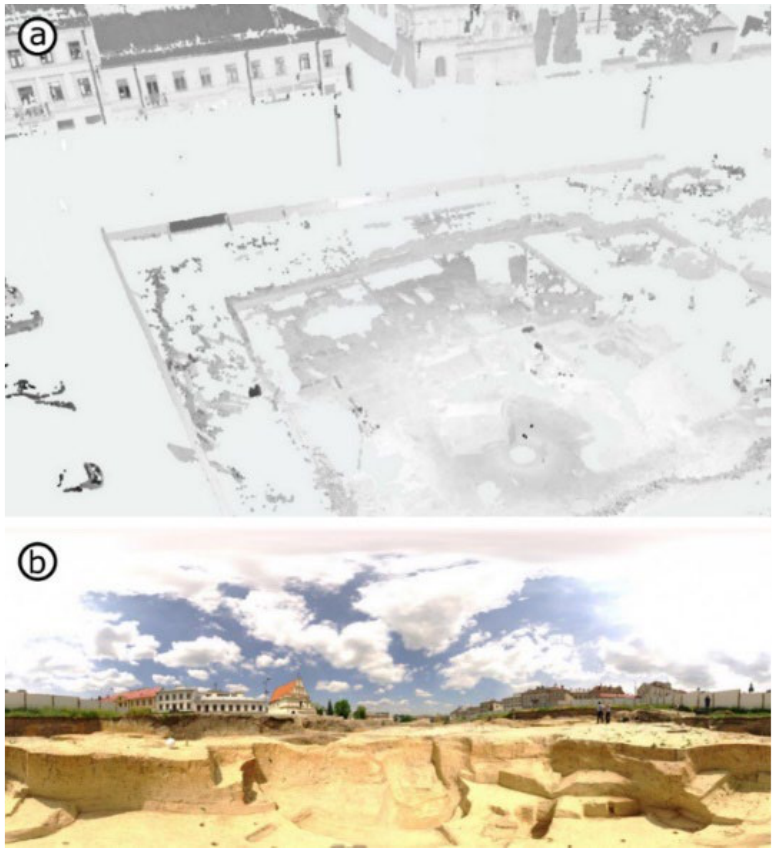
Figure 2. Exemplary data obtained with TLS scanning (excavations in Lublin, Poland): ( a ) a three- dimensional point cloud with a brightness level, ( b ) panoramic image of the surroundings to colour the scan. Source: authors’ own.